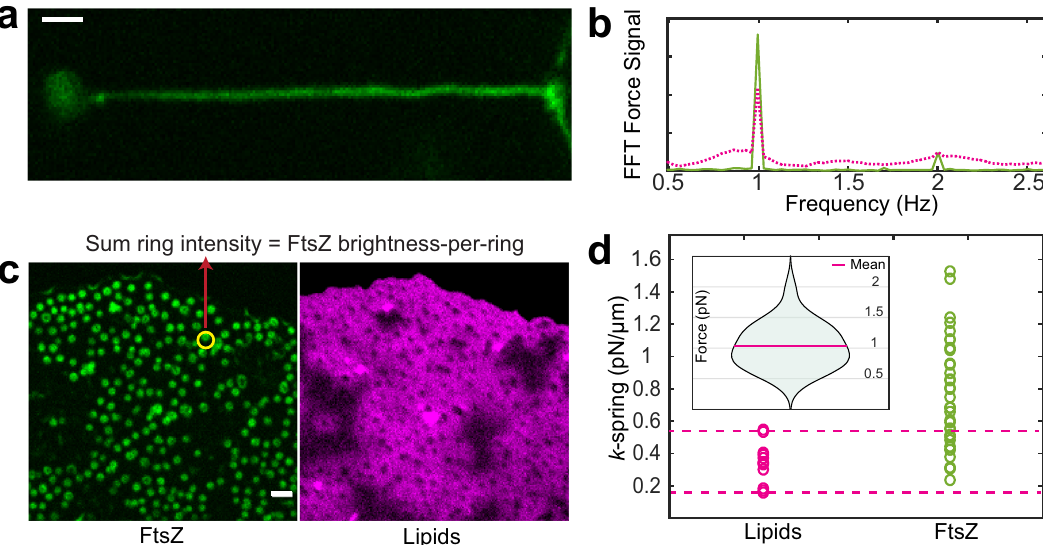
Fig. 4 Dynamic FtsZ-YFP-mts rings exert forces in the pN range. a Spring-like structures ( N = 36) were mechanically assessed by forcing the tube length to oscillate with an amplitude of 3 μ m and a frequency of 1Hz. To measure a reliable force contribution from the protein, we increased the protein sample concentration (see “ Methods ” ) to guarantee a full/high protein coverage of the tube. b To measure forces, we tracked bead-displacement as response of the dynamic input. Then we Fast Fourier-transformed (FFT) the data to calculate the amplitude of the signal. Magenta line: lipid signal and green line: FtsZ. c Spontaneous fl attening of vesicles over the glass surface permitted to characterize the total brightness of single rings ( N = 412) with exactly same conditions as lipid tube experiments. d By calculating the amplitude of each FFT force signal ( b ), we assessed the spring constant for the case of the only lipid contribution ( N = 11) and FtsZ ( N = 36). Dashed magenta lines indicate the range where the lipid response dominated over the FtsZ contribution to the spring constant. ( d — insert) The total FtsZ brightness for each data point in ( d ) was determined to approximate the FtsZ brightness-per-ring in accordance with Fig. S2E. Thus, the distribution of forces/ FtsZ brightness-per-ring was plotted ( N = 23) showing a mean value around 1pN per ring unit. (Scale bar = 2 µ